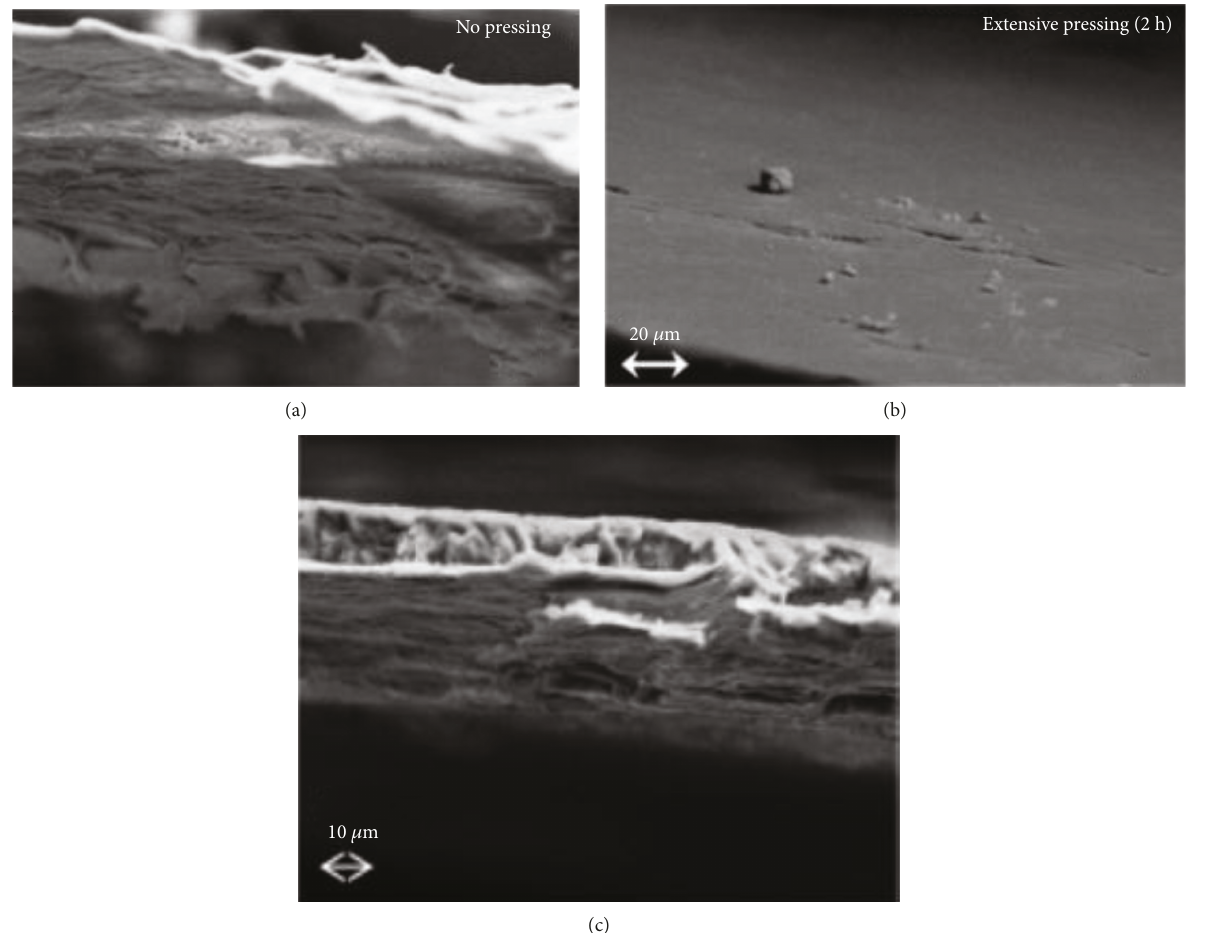
Figure 15: FE-SEM micrographs of cellulose nano fi bre nanopaper sections acquired: (a) on pristine nanopaper; (b) after hot-pressing for two hours; (c) after hot-pressing and deposition of a para ffi n wax on nanopaper surface. Reproduced from reference [50] with permission from the American Chemical